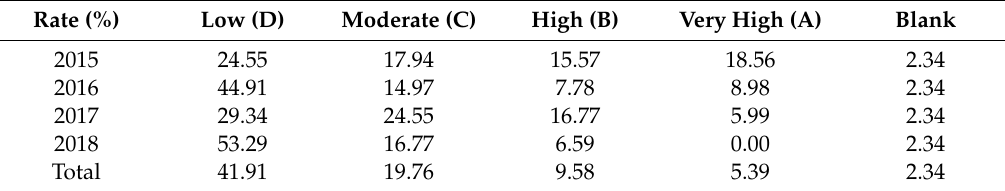
Table 7. Frequency of agricultural drought